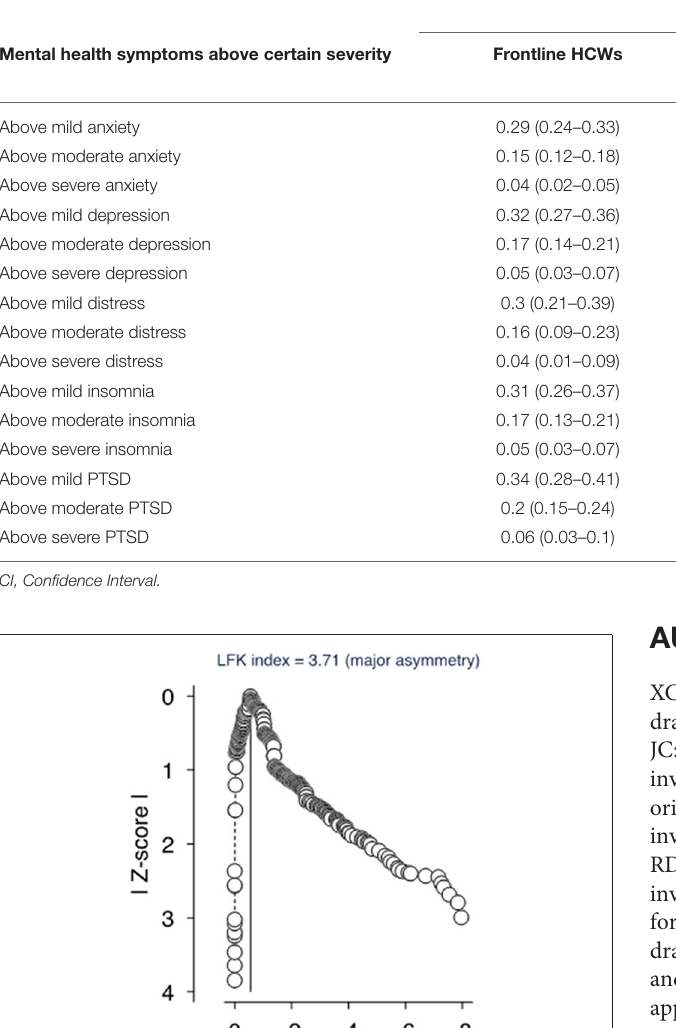
TABLE 4 | The predicted prevalence rates of mental health symptoms by populations, outcomes, and severity by the meta-analytical regression model.